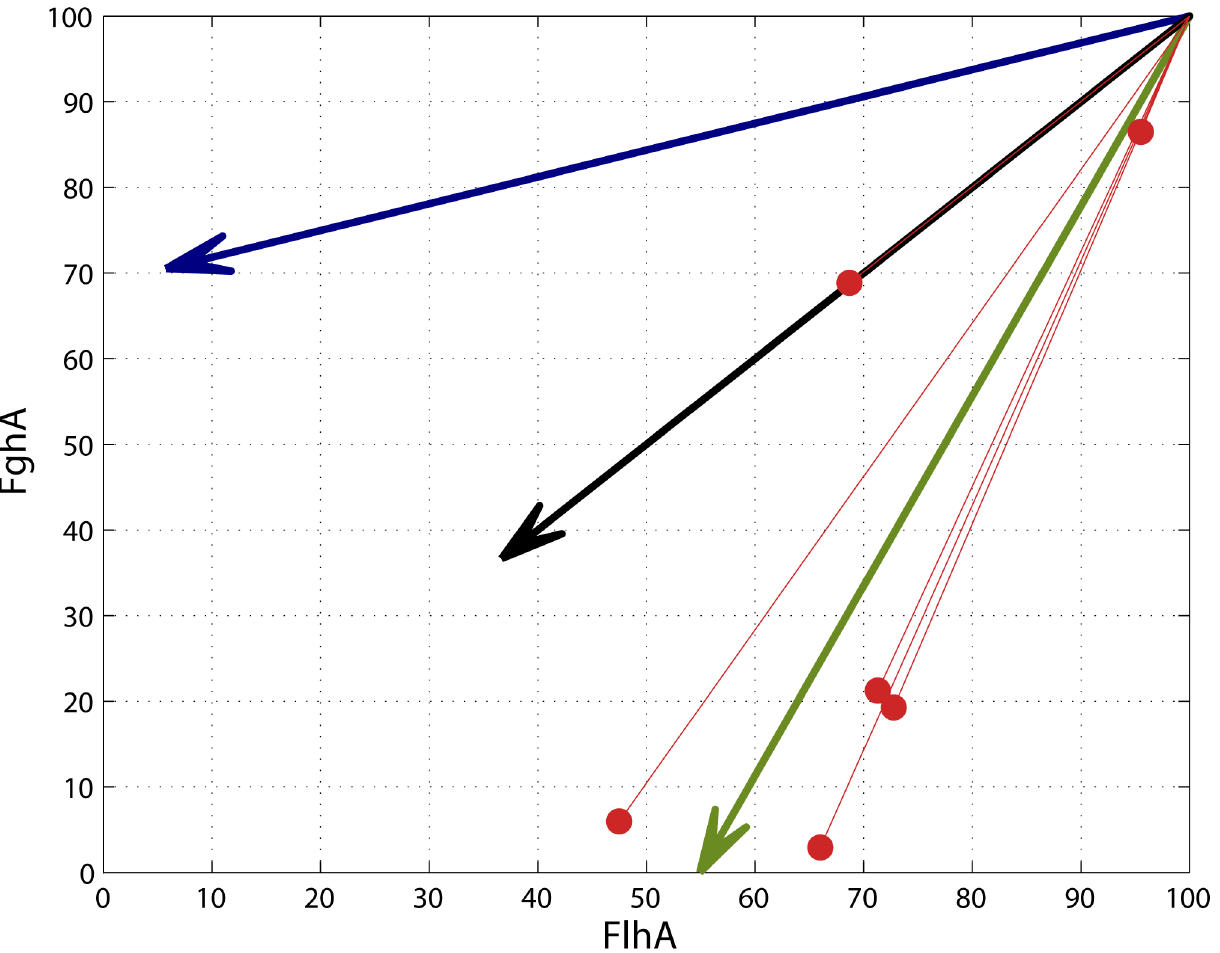
Figure 5. Adaptive mutations tended to move phenotypes toward the global optimum. The direction of phenotypic movements for strains with single mutations (red lines; enzyme levels of ancestor set to 100) are compared to the vectors indicating of the locally steepest fitness gradient for the ancestor (blue), complete 1:1 correlation between phenotypes (black), and the global optimum (green). The direction of phenotypic movement for all single mutations was closer to the vector for the global optimum relative to the local gradient around the